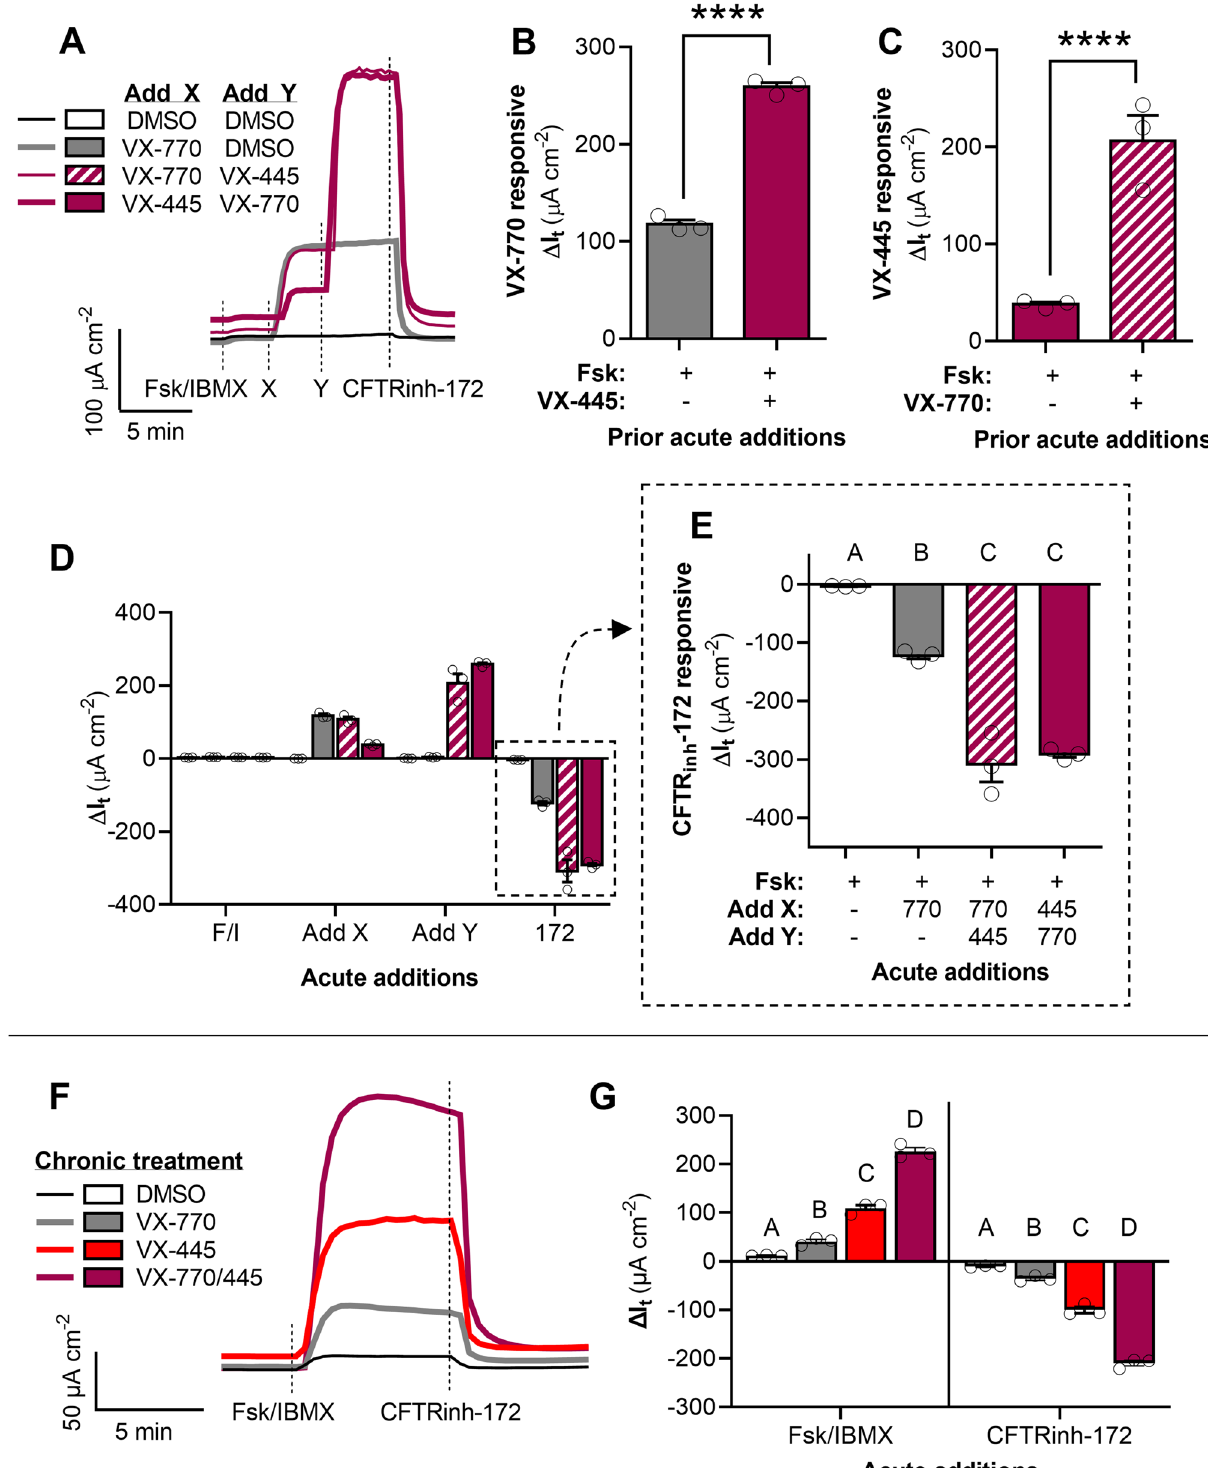
Figure 3. Synergism of ivacaftor (VX-770) and elexacaftor (VX-445) in potentiating G551D-CFTR in FRT cells. ( A ) Representative I t recordings of FRT cells expressing human G551D-CFTR showing acute actions of VX-770 and VX-445. ( B–C ) Changes in I t after acute addition of VX-770 in the absence and presence of VX-445 ( B ) and in response to the acute addition of VX-445 in the absence and presence of VX-770 ( C ). ( D–E ) Changes in I t after the additions of test compounds for the experiment presented in ( A) . G551D-CFTR mediated I t is greatest after acute potentiation by both VX-770 and VX-445. ( F ) Representative I t recordings of FRT cells expressing human G551D-CFTR treated for 24 h with DMSO, VX-770, and/or VX-445. ( G ) Changes in I t after the additions of test compounds for the experiment presented in ( F) . G551D-CFTR mediated I t is greatest after chronic treatment by both VX-770 and VX-445. See SI for additional experimental details and for supporting data. All data are presented as mean ± standard error. Bars with different letters (A, B, C…) are significantly different from each other (ANOVA; P < 0.05). Asterisks indicate specific P values: **** P <